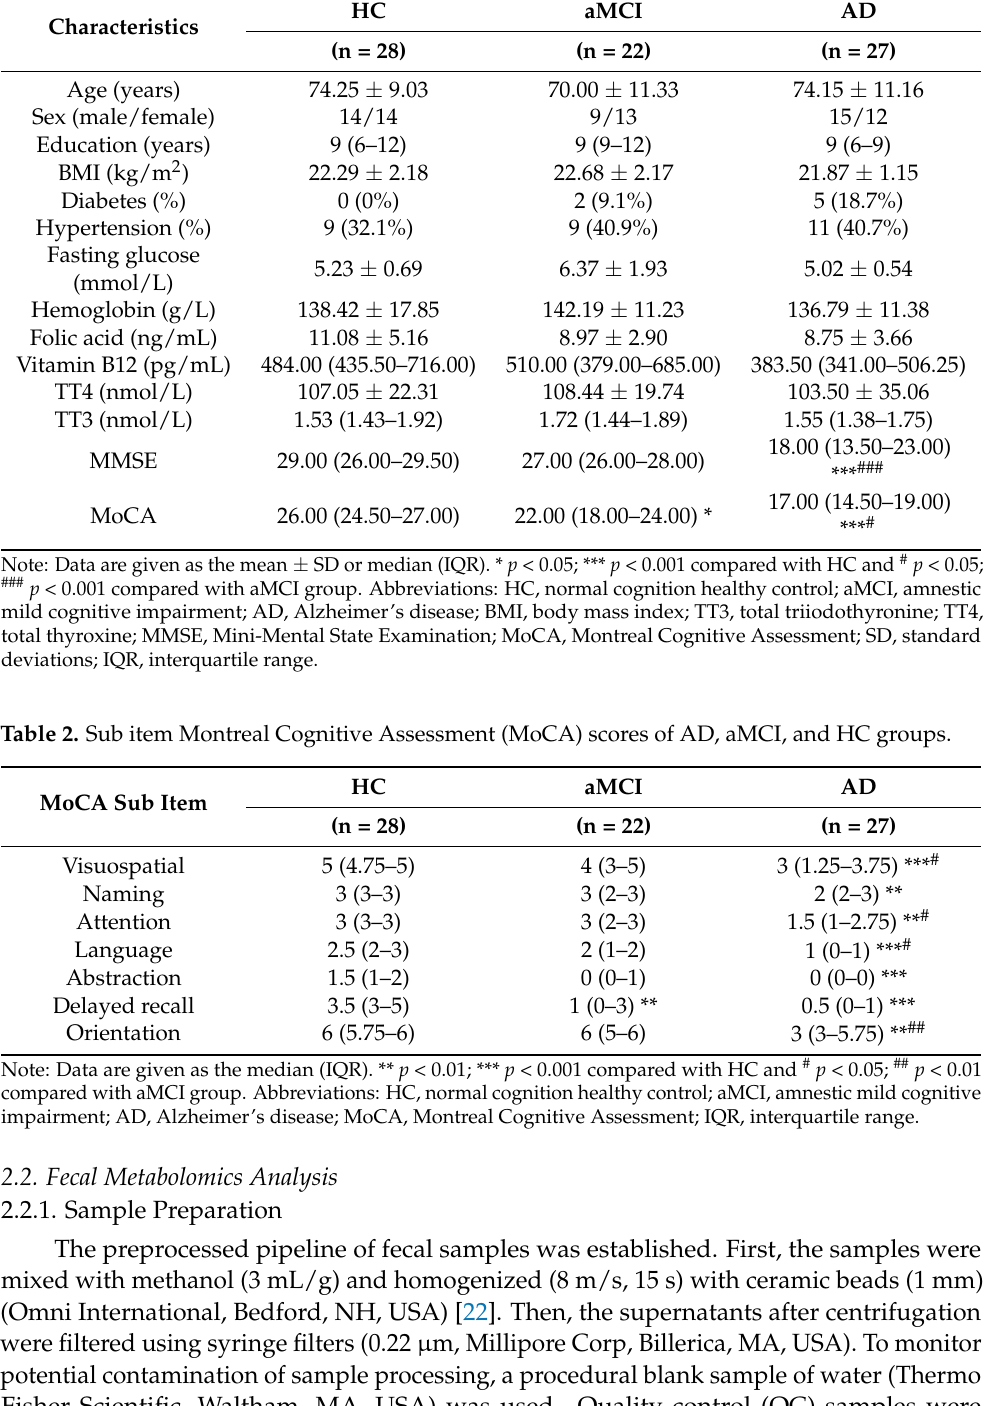
Table 1. Demographics and clinical parameters of subjects in the Alzheimer’s disease (AD), amnestic mild cognitive impairment (aMCI), and normal cognition healthy control (HC) groups. Characteristics